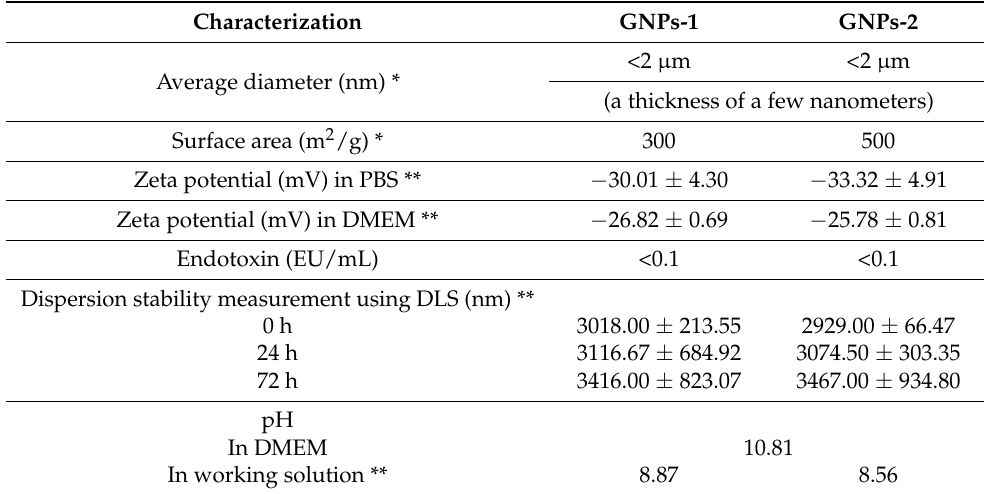
Table 2. Physicochemical characterization of the graphene nanomaterials.